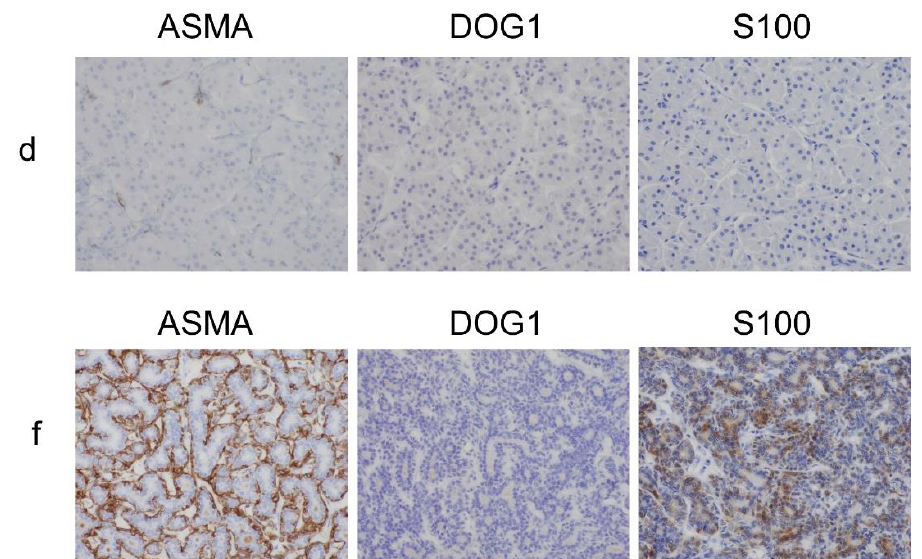
Figure 3. ( d ) Immunoreactivities of ASMA, DOG1 and S100 in the oncocytic component. 400 × magnification. ( f ) Immunoreactivities of ASMA, DOG1 and S100 in ducts “nodule -in- nodule“ structure. 400 × magnification. Table 1. The summary of antigen retrieval. PA primary antibody, ER1 Epitope. retrieval 1 pH6.0,